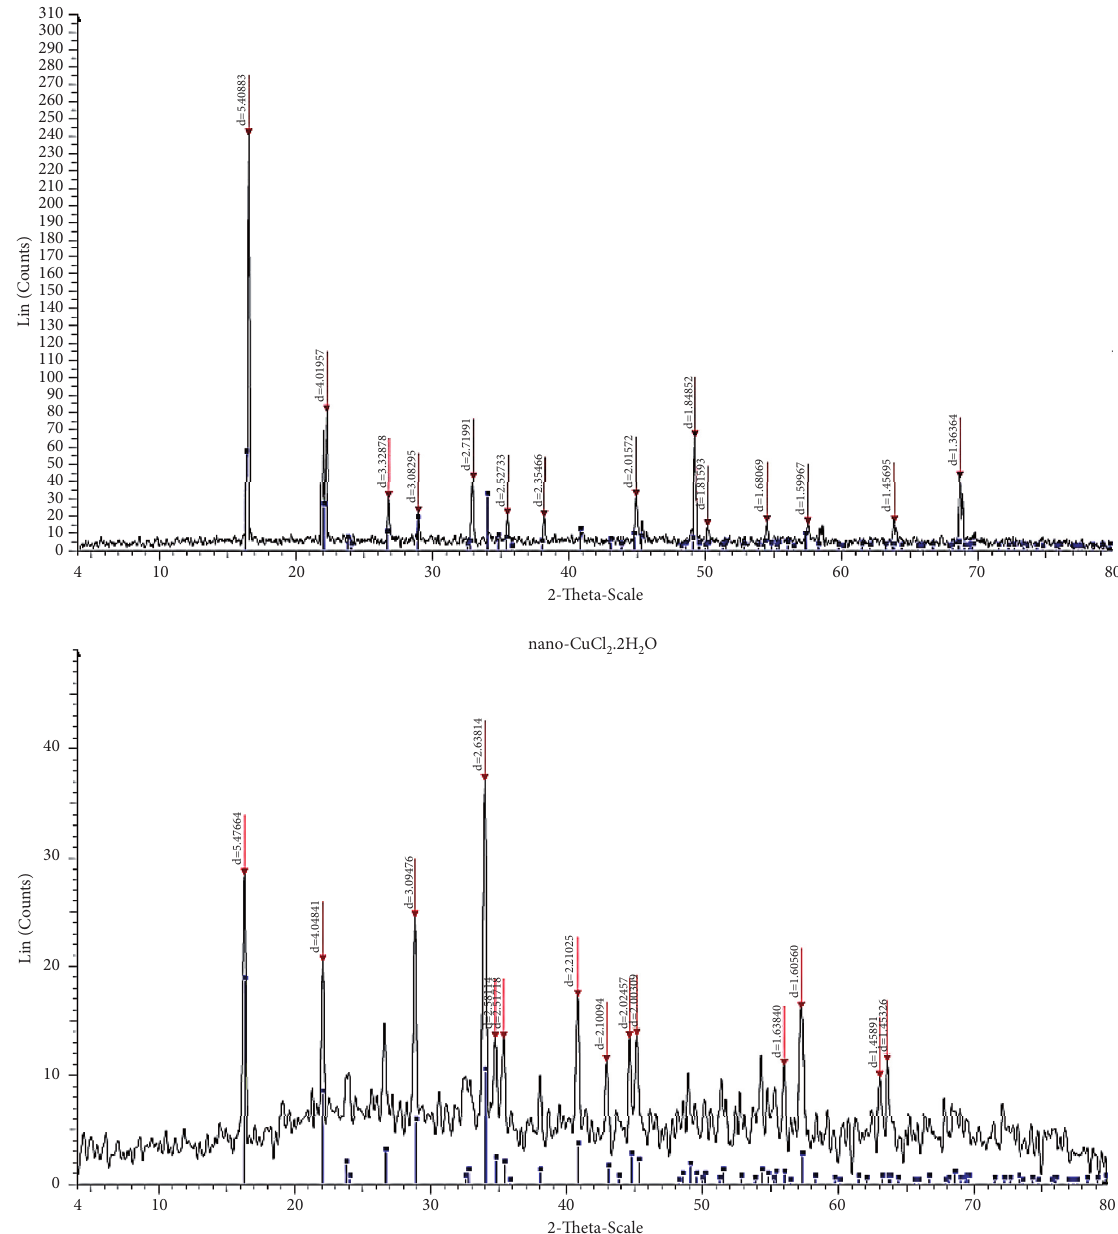
Figure 2: X-Ray diffraction of bulk and nano-CuCl Table 2: Intensity (%) and crystal size (nm) of bulk and nano-CuCl